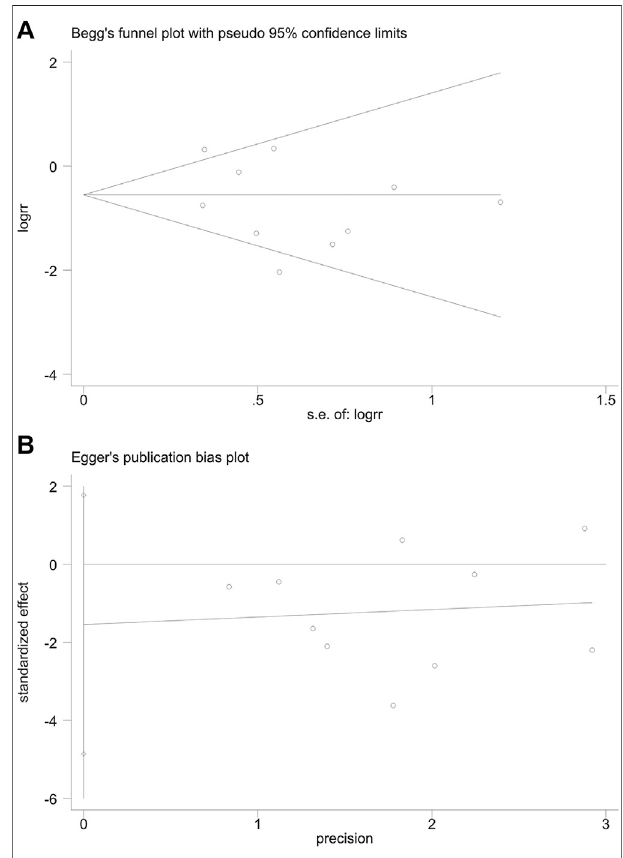
FIGURE 13 | Publication bias. (A) The Begg ’ s test on incidence of adverse reactions. (B) The Egger ’ s test on incidence of adverse reactions.